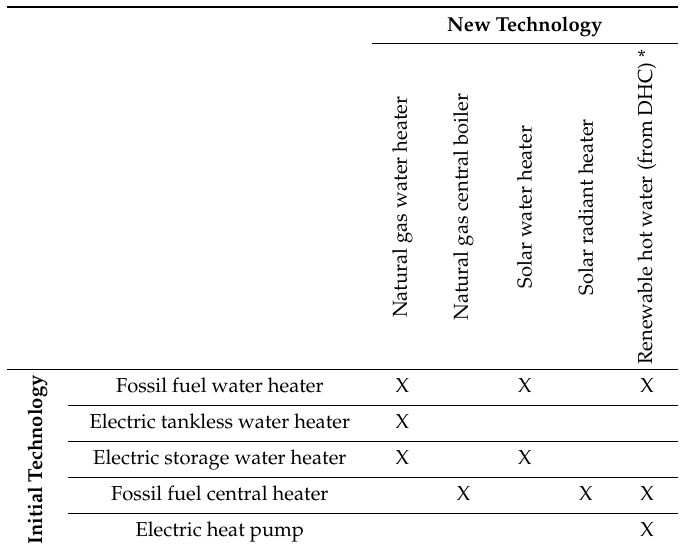
Table 1. Most common technology